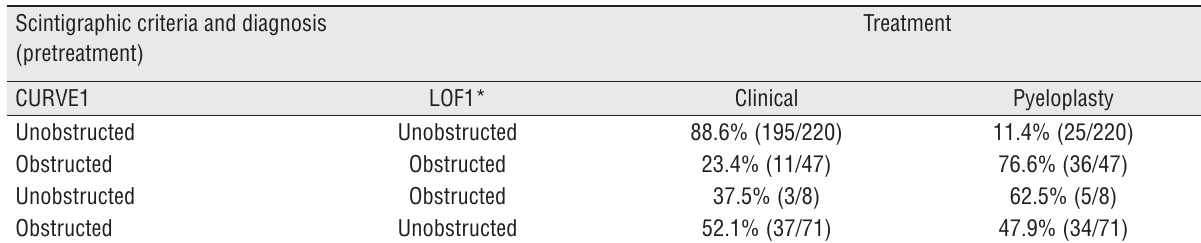
cURvE1: renal curves in the first scan. LOf1: output fraction in the first scan. * a LOF ≤ 12.4% was considered as